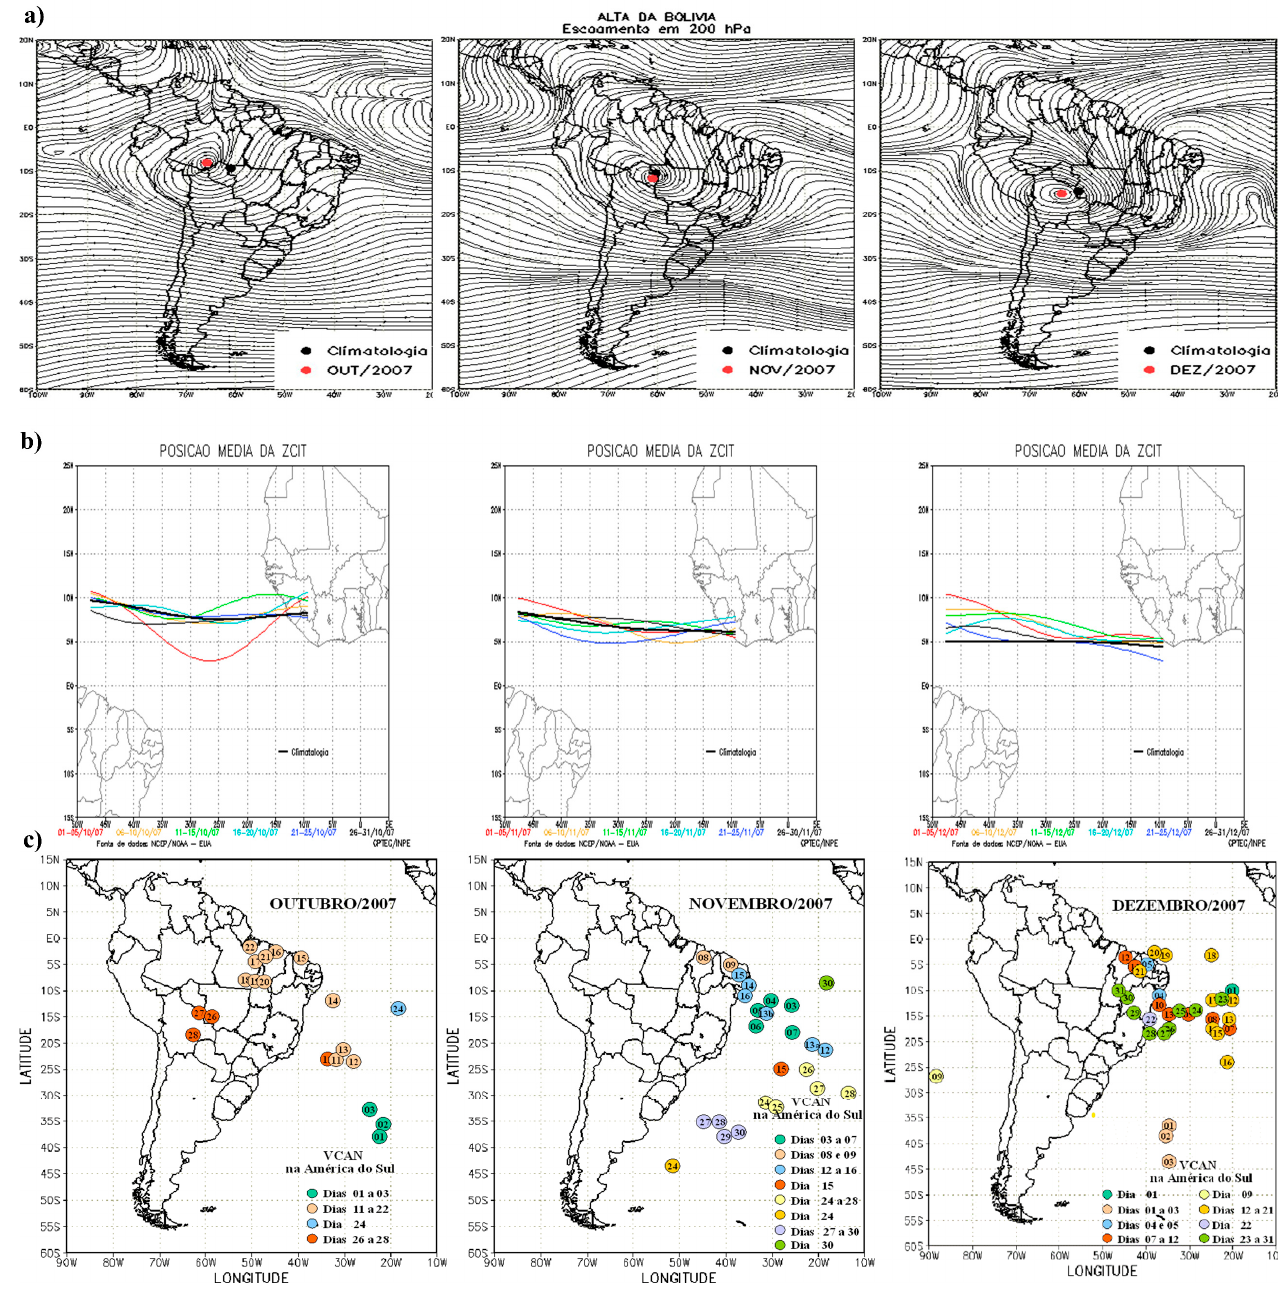
Figure 6. ( a ) Position of the AB in the months of October, November and December for 2007. ( b ) Position of the ITCZ in the months of October, November and December for 2007. ( c ) Position of the VCANs in the months of October, November and December for 2007. Source: [36].